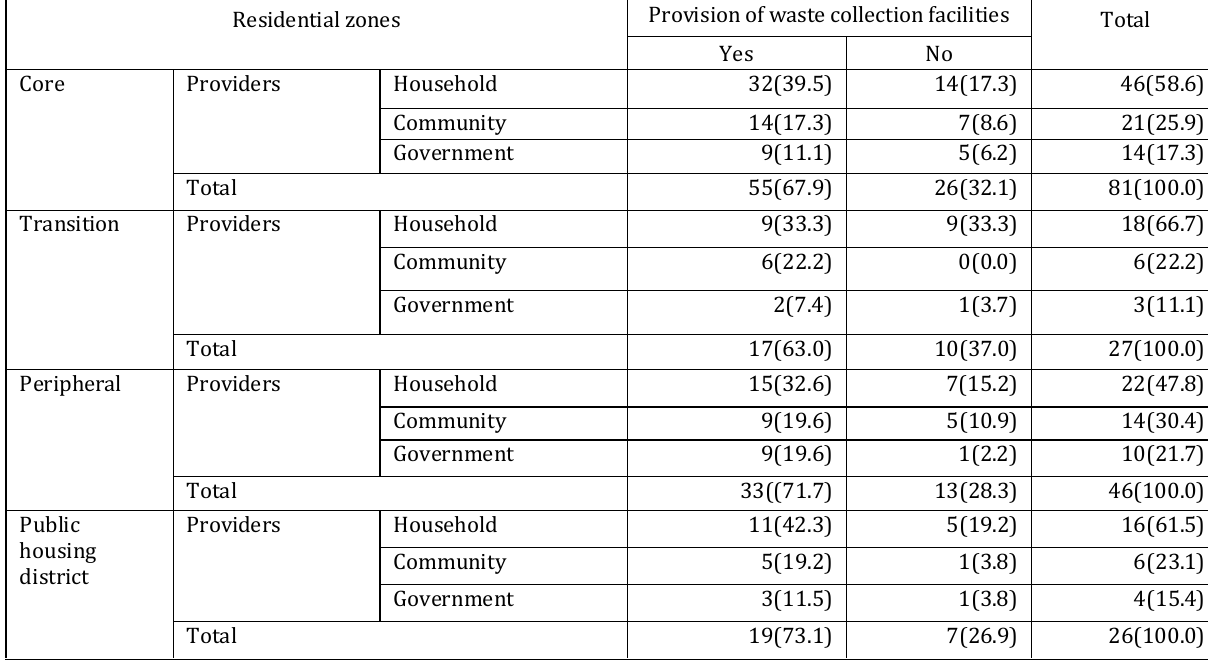
Table 9. Providers of waste collection facilities across residential zones